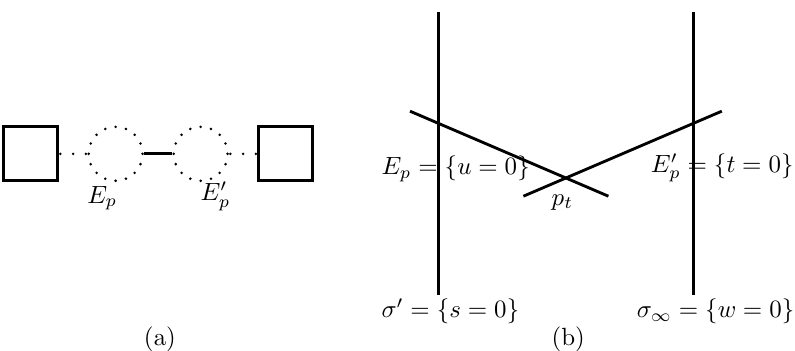
Figure 4. (a) The Dynkin diagram for elementary E-strings. Dotted nodes denote the P 1 cycles, on which a wrapped D3-brane yields an E-string. The lines denote the intersection between cycles. In particular, the solid line is to be interpreted as an M5-brane. The boxes are cycles supporting E 8 symmetries. (b) A dual graph highlights the intersection structure of these cycles, which are denoted by lines. The coordinates will be used in the